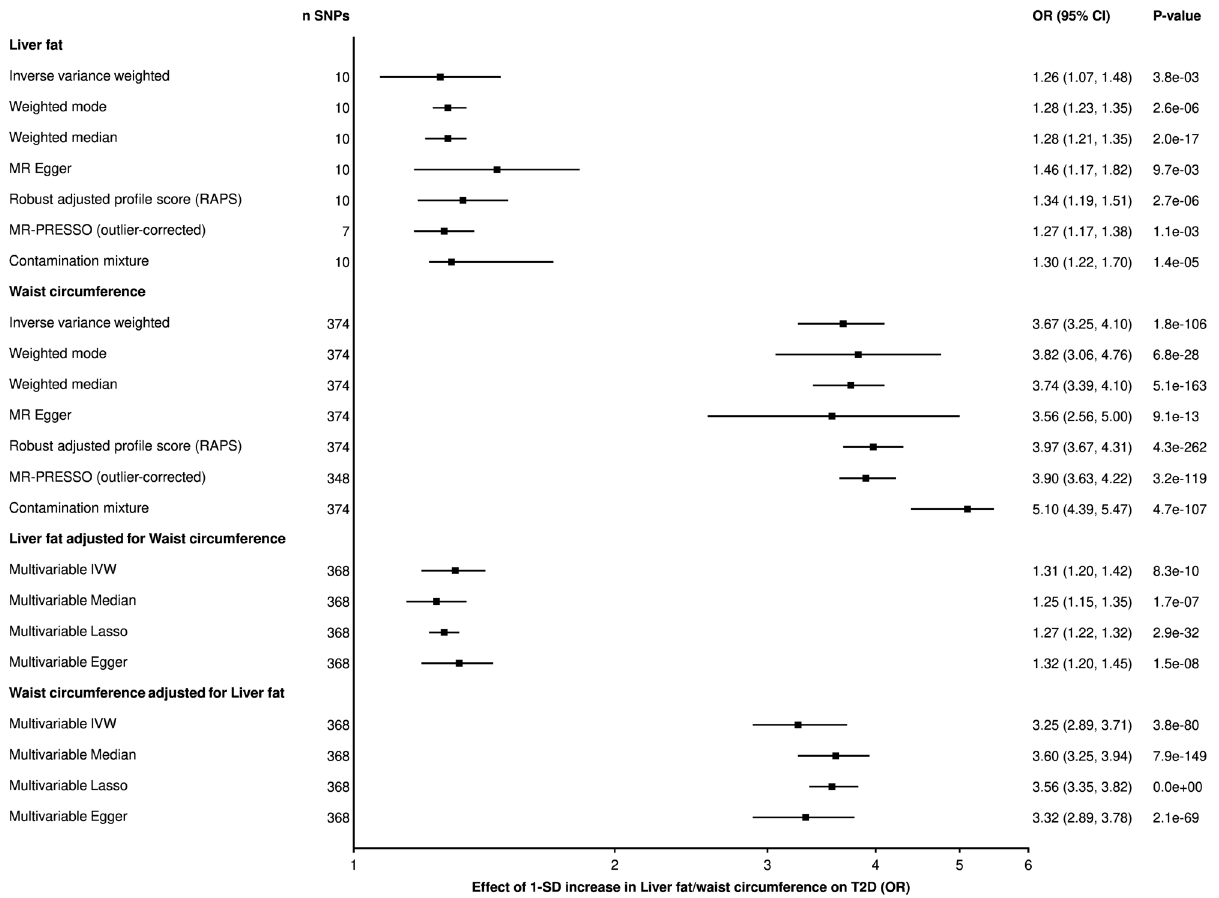
Fig. 4 Causal effect of 1-SD increase of waist circumference and liver fat accumulation on type 2 diabetes (T2D) using univariable and multivariable Mendelian randomization (MR). The effect of genetically-predicted waist circumference and liver fat accumulation on T2D using multiple robust MR methods is presented in the top panels and the effect of genetically-predicted waist circumference and liver fat accumulation on T2D using multiple robust multivariable MR methods is presented in the bottom panels. Error bars are 95% con fi dence